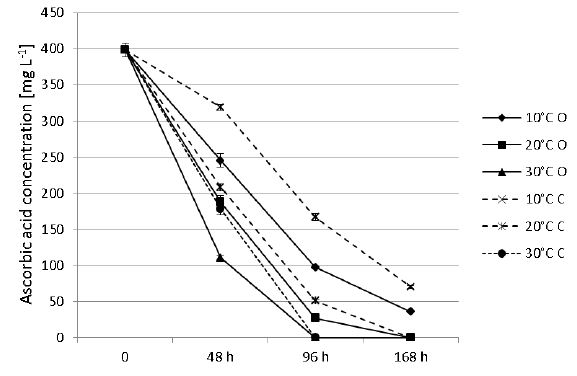
Figure 8: Changes in the concentration of ascorbic acid during storage of freshly squeezed lemon juice in open (O) and closed (C) containers.